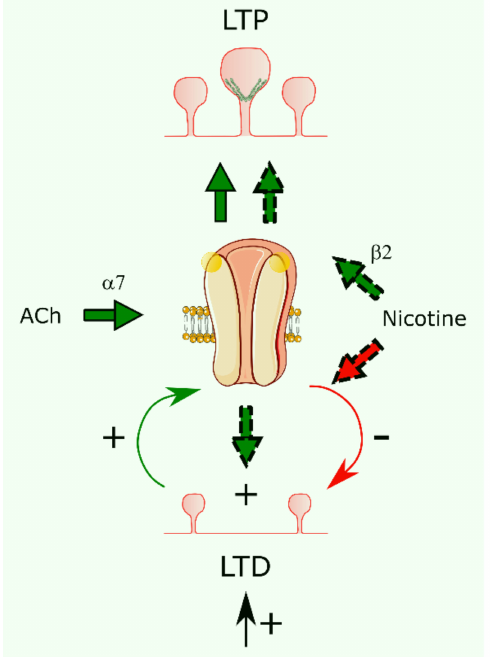
Figure 4. Modulation of synaptic plasticity by cholinergic agonists. Induction of long-term depression (LTD) stimulates α 7 nAChR, which, in turn, inhibits LTD (solid line arrows). Nicotine application releases the inhibition and increases LTD (dash line arrows). Long-term potentiation (LTP) can be induced by the endogenous release of ACh through homomeric α 7 nAChRs or by nicotine through β 2-containing heteromeric